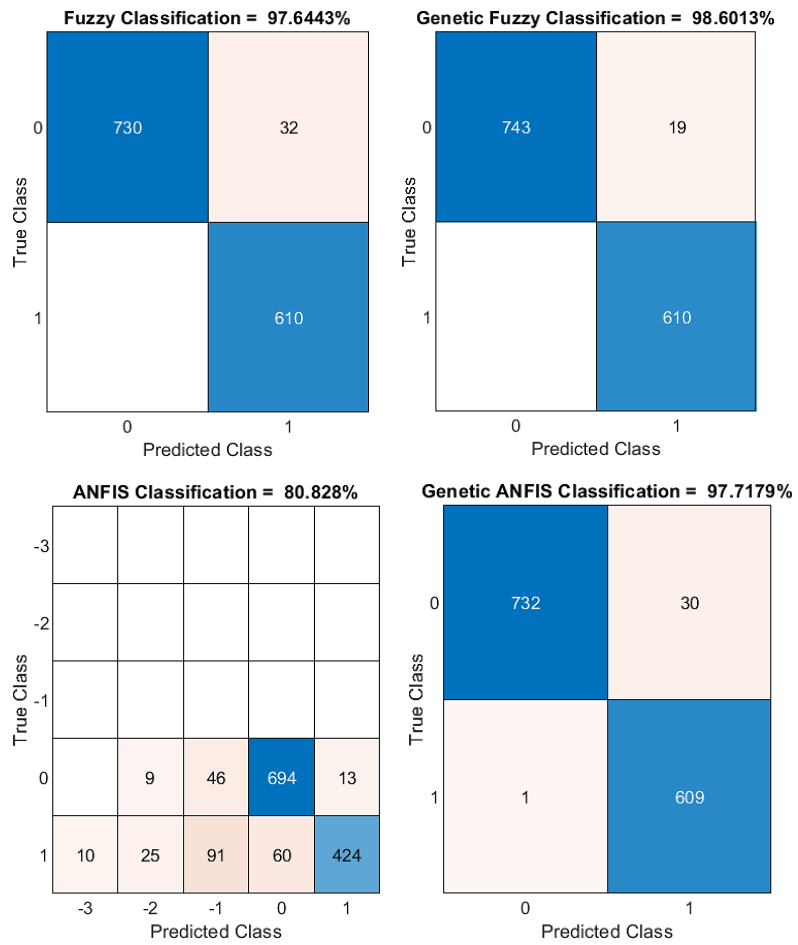
Fig. 6. Confusion matrix for detecting counterfeit